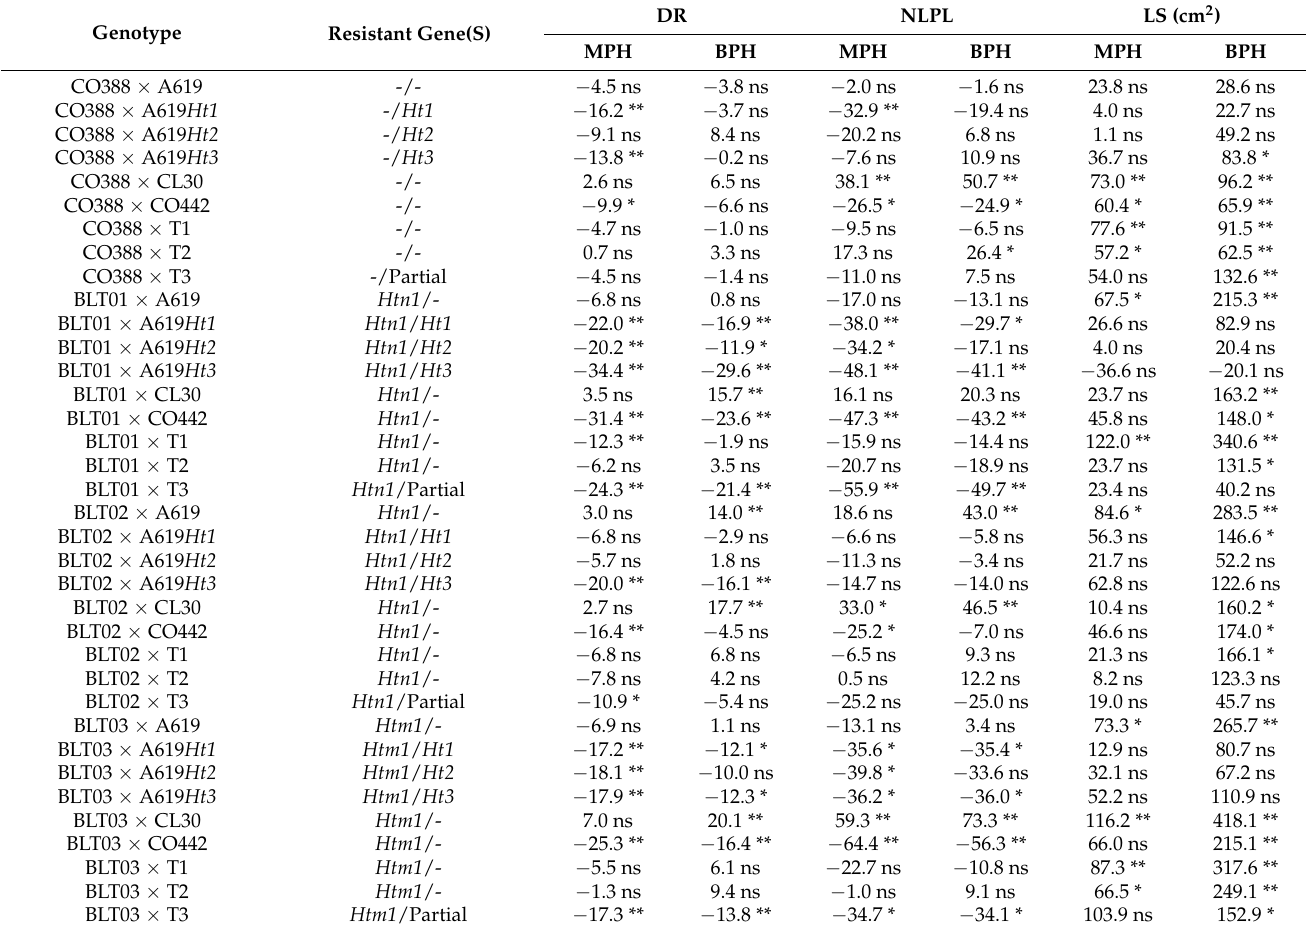
related and 42 CO428-related Line × Tester crosses for disease rating (DR), number of lesions per